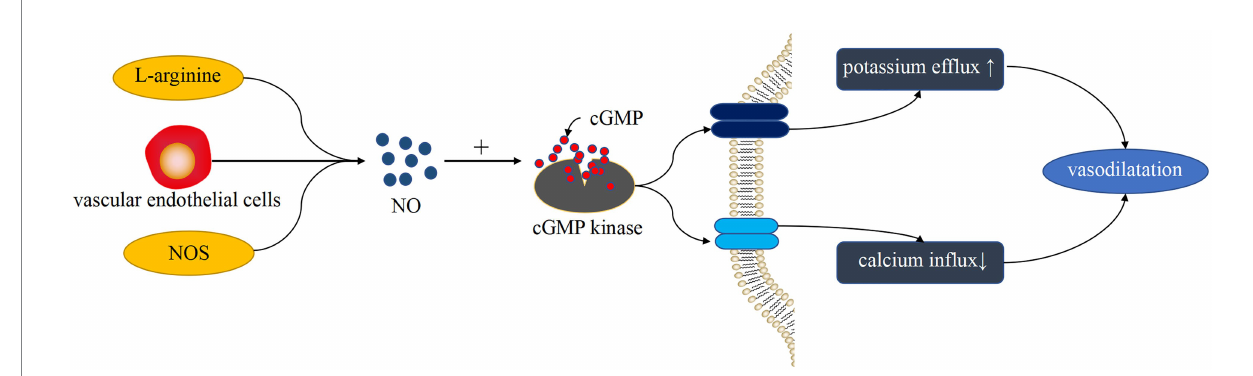
FIGURE 2 Vasodilation-induced pathways of NO. l -arginine generates NO under the catalysis of NOS. NO production is also affected by ET-1 produced by endothelial cells. NO plays a role through the cGMP-cGMP kinase pathway, which causes K + and Ca 2+ transport imbalance, resulting in